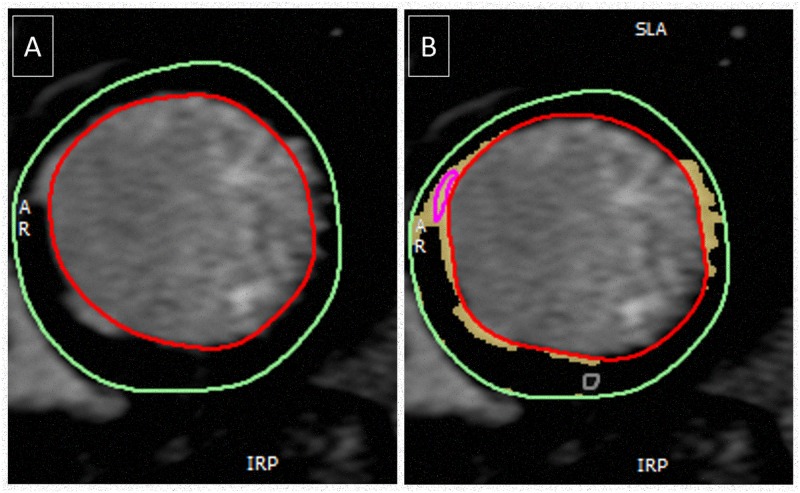
Example demonstrating the quantification of the left ventricular myocardium.Panel A shows the visual late gadolinium enhancement whilst panel B shows the quantified enhanced mass. Once completed for all the myocardial slices then the overall absolute enhanced mass or % mass can be calculated.